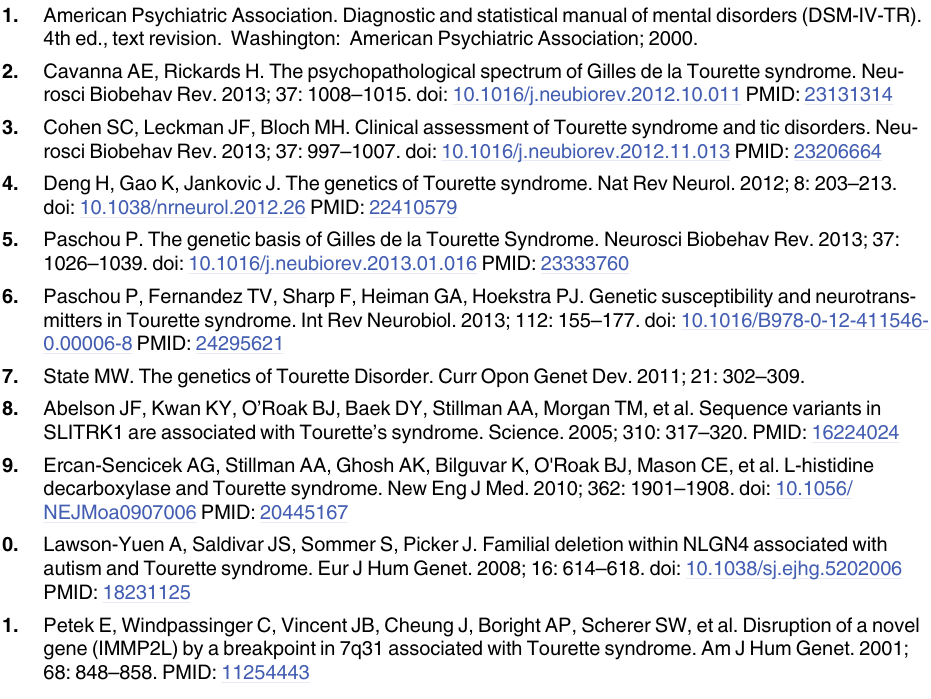
S1 Table. Primers used for PCR amplification and sequencing. S2 Table. Dataset of raw values underlying the findings of the